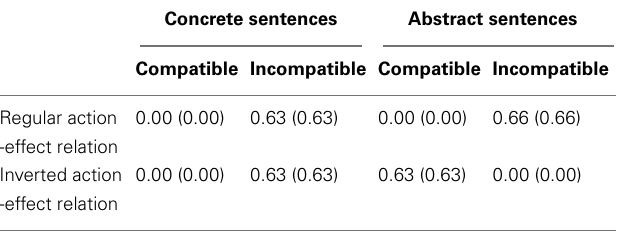
Table 1 | Mean error rates (in %) and standard errors of error rates (in parentheses) in Experiment